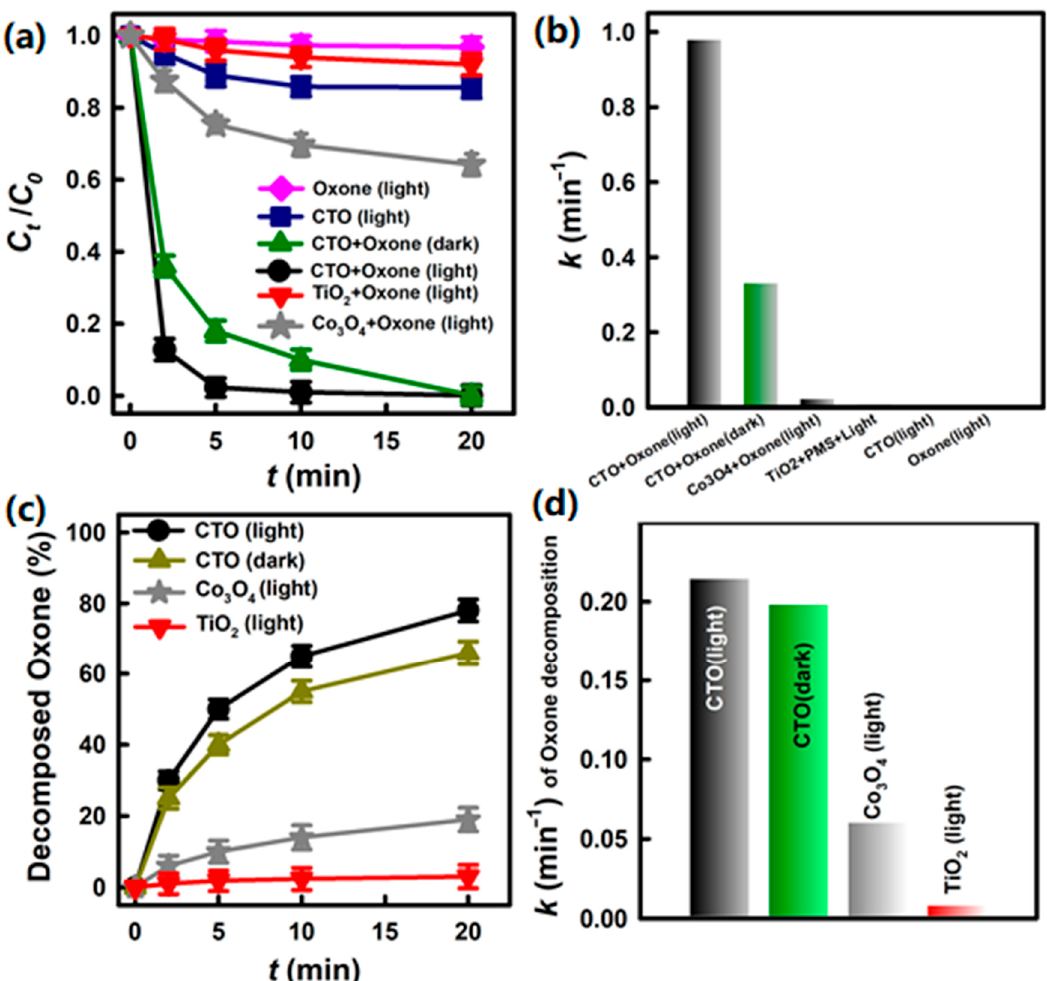
Figure 5. ( a ) Comparison of BHPM degradation by oxone alone, adsorption to catalysts, and oxone activated by CTO, TiO 2 , and Co 3 O 4 ; ( b ) rate constant of BHPM degradation using oxone activated by catalysts (catalyst = 200 mg/L, oxone = 200 mg/L, T = 300 K); ( c ) decomposition of oxone by different catalysts; and ( d ) rate constants of oxone decomposition by catalysts.